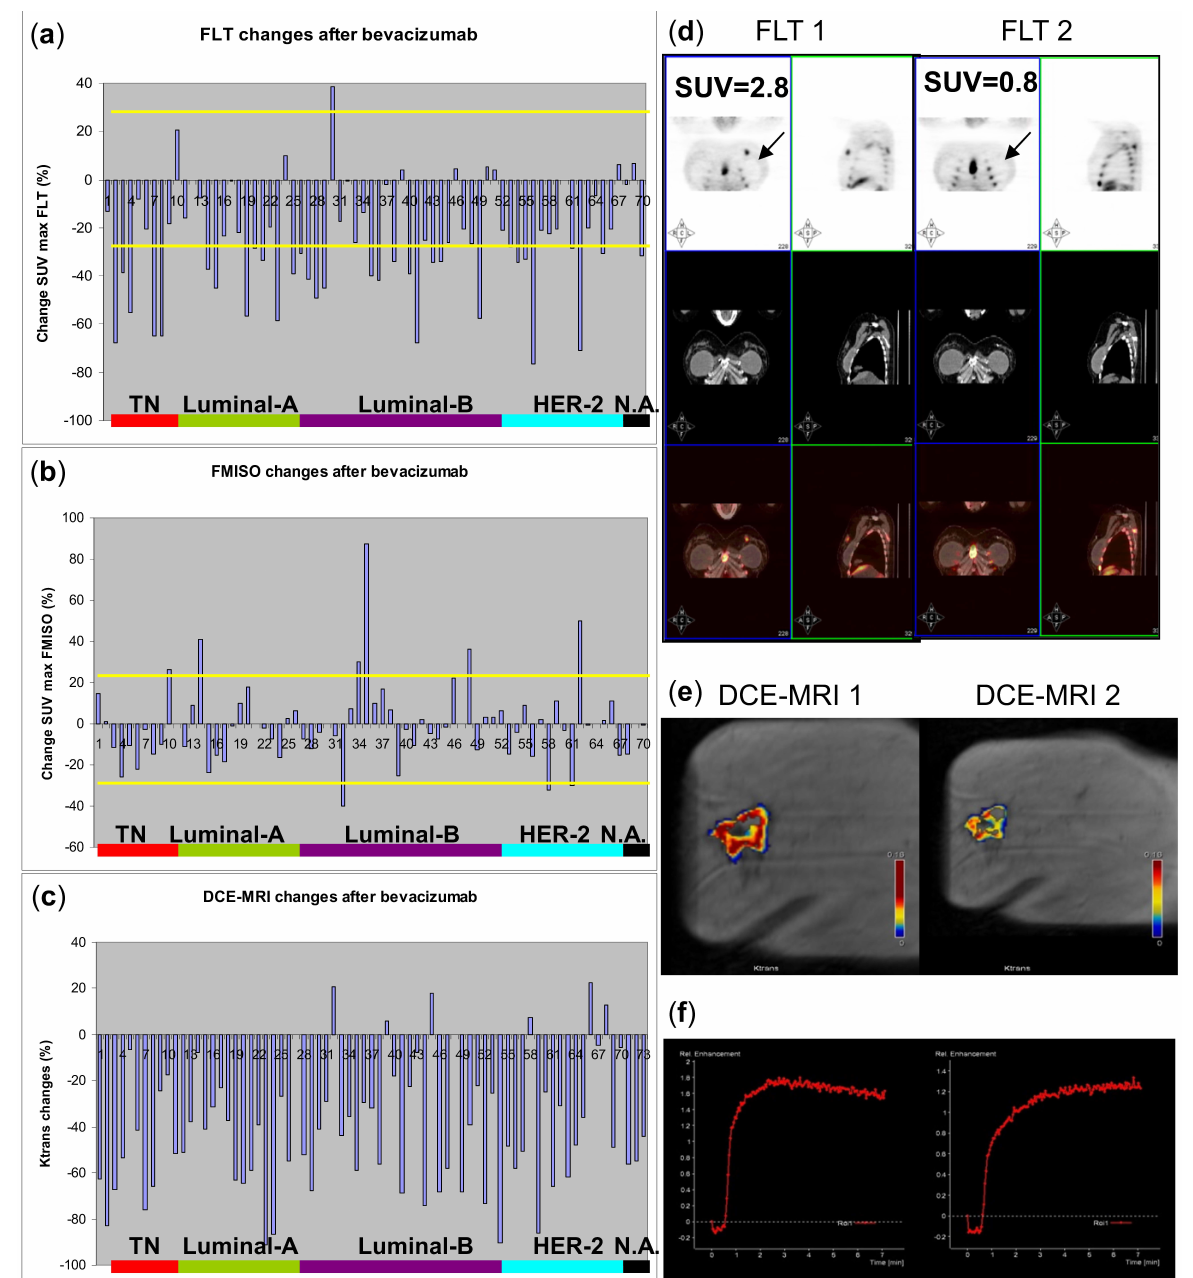
Figure 1. Waterfall plots of changes in ( a ) FLT and ( b ) FMISO SUV max , and ( c ) DCE-MRI K trans at baseline and after treatment by clinical subtype in patients. Example of a patient showing similar levels of response in both ( d ) FLT-PET and ( e , f ) DCE-MRI parameters. ( d ) shows important decreases in FLT SUV max after bevacizumab; ( e ) shows changes in the same patient in K trans before (DCE-MRI 1) and after bevacizumab (DCE-MRI 2). DCE-MRI, dynamic contrast- enhanced magnetic resonance imaging; FLT, 18 F- fluoro-3 (cid:48) -deoxy-3 (cid:48) -L-fluorothymidine; FMISO, 18 F-fluoromisonidazol; HER2, human epidermal growth factor receptor 2; K trans , volume transfer constant; PET, positron emission tomography; SUV max , maximum standardised uptake; TNBC, triple negative breast